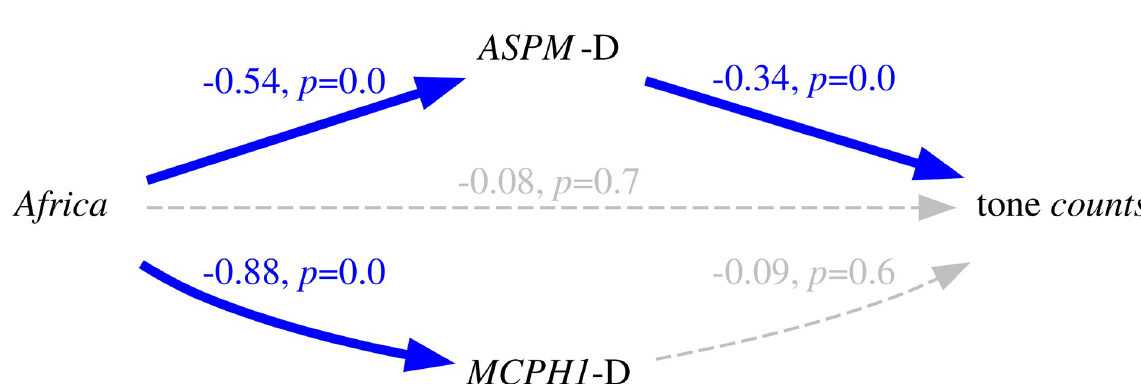
Fig 30. The path model for tone counts fitted on all the data. Same conventions as in Fig 13.